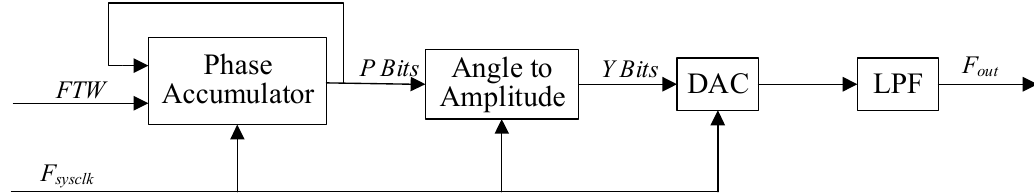
Figure 2. Functional block diagram of traditional DDS method.